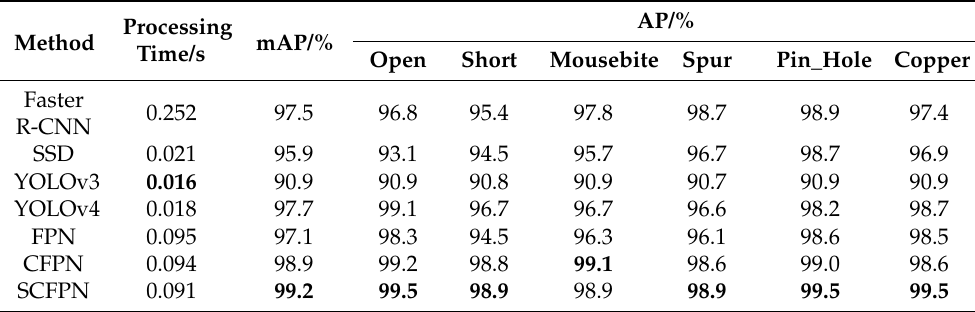
Table 2. Experimental evaluation metrics of different detection networks on DeepPCB. The bolded values are the best results in their respective